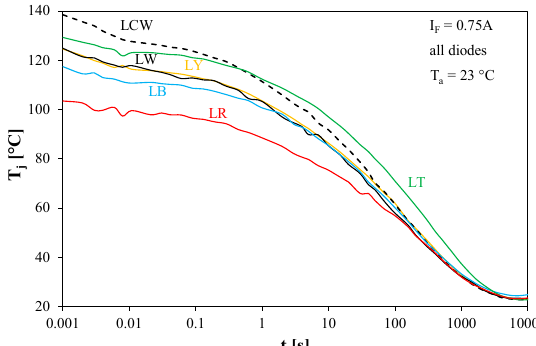
Figure 16. Measured waveforms of internal temperature of all the tested power LEDs while cooling after power supplying all the diodes.